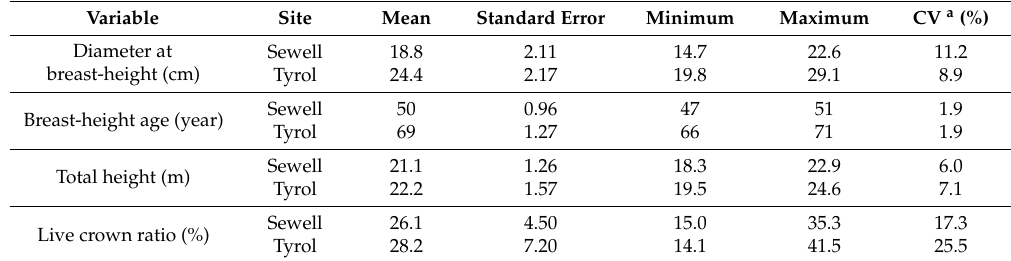
Table 3. Descriptive statistical summary of the mensuration characteristics of the 61 sample trees by site ( n = 31 and 30 for Sewell and Tyrol, respectively).